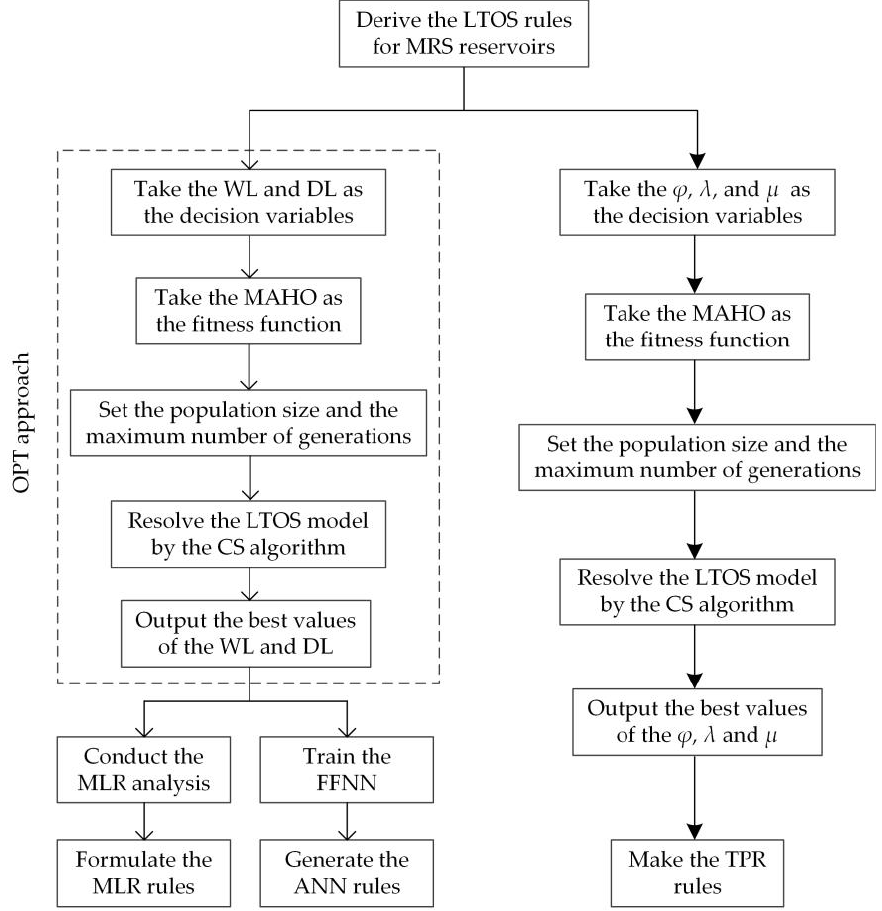
Figure 2. Flow chart of deriving the MLR, ANN, and TPR rules.